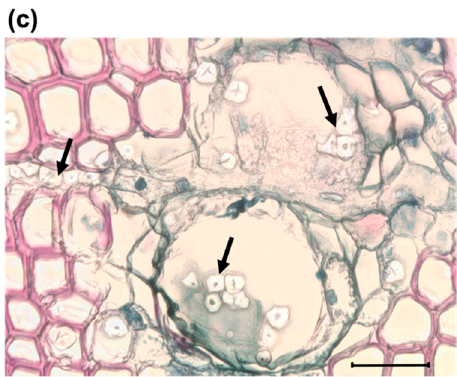
Figure 5. Transverse section of P. strobus sapwood stained with rhodamine B and methyl green ( a ) O. minus inoculated trees after 65 dpi showing fungal hyphae (arrowhead) in xylem rays. ( b ) Inoculated trees showing several starch granules (black arrows) in resin ducts and ( c ) Control (non-inoculated). Magnification 40×; scale bar 50 m. Abbreviations : X, xylem; R, ray parenchyma.